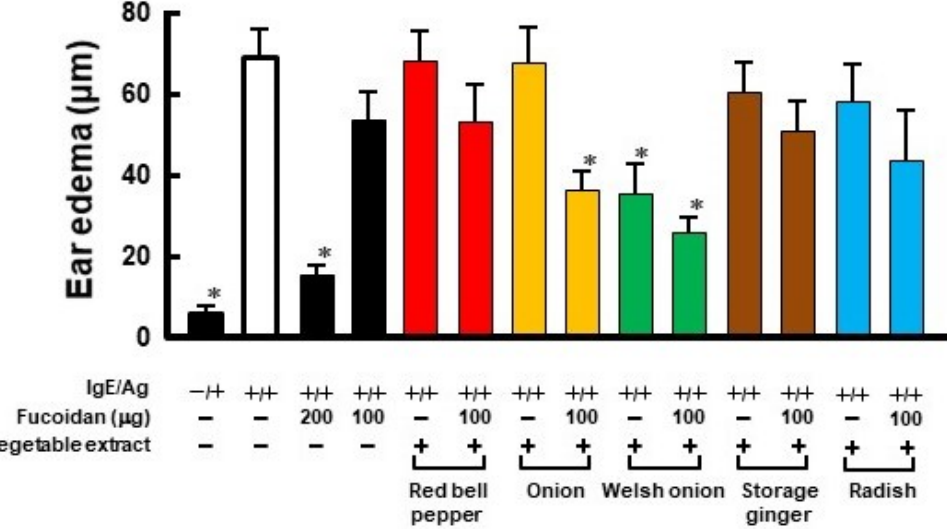
Figure 1. Anti-allergic activity of vegetable extracts in PCA reaction. Mice were orally administered test samples for 4 days and PCA reaction was conducted. Each vegetable extract dose was determined by converting it to correspond to the amount of extract extracted from 1 g of fresh vegetables. Ear edema was evaluated 2 h after antigen challenge. Values represent the means ± SE of 5 mice in each group. * p < 0.05, significant differences from the values of the group of IgE/Ag.